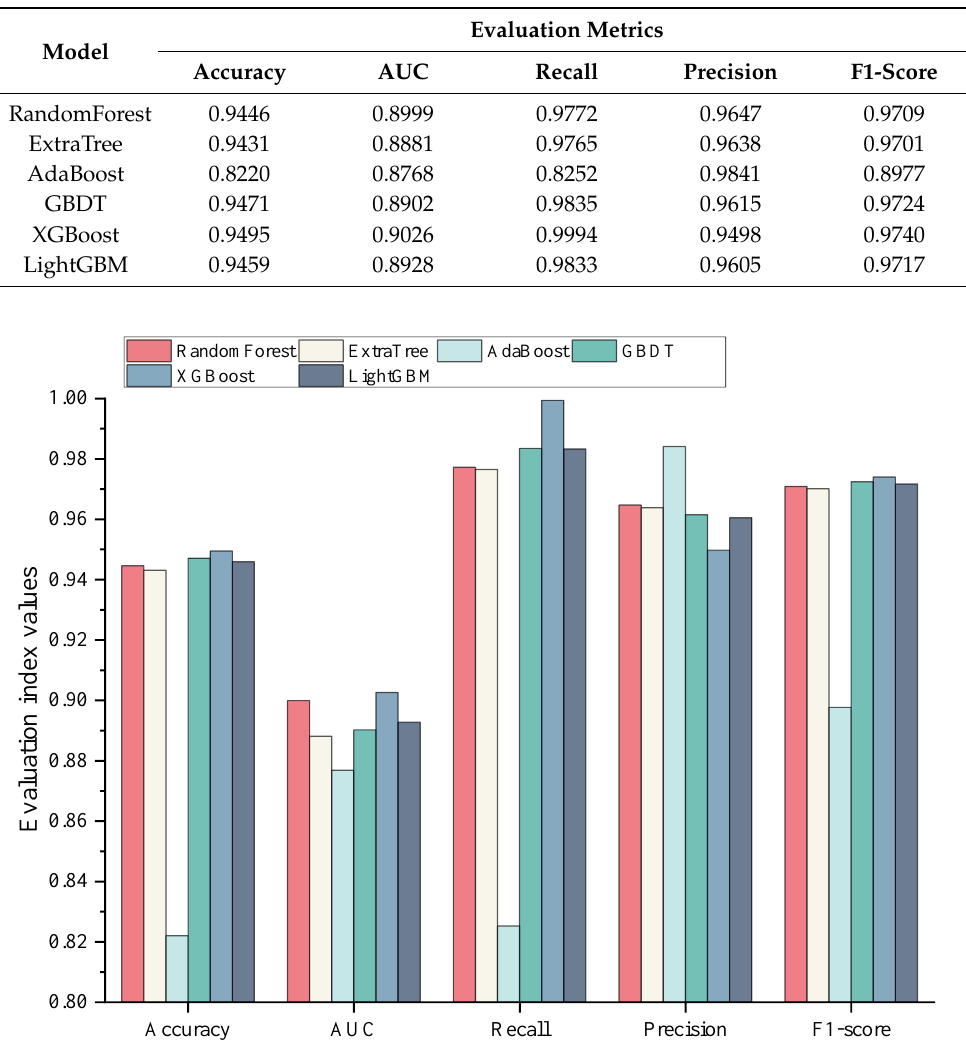
Figure 4. Evaluation results of the ensemble learning models on the test set.